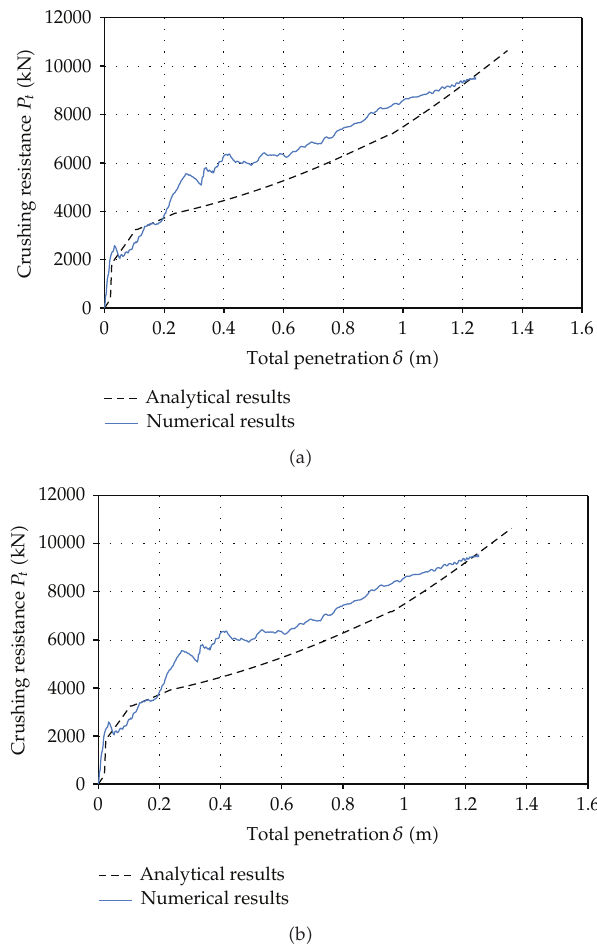
Figure 32: Comparison of the analytical and numerical crushing forces for gate